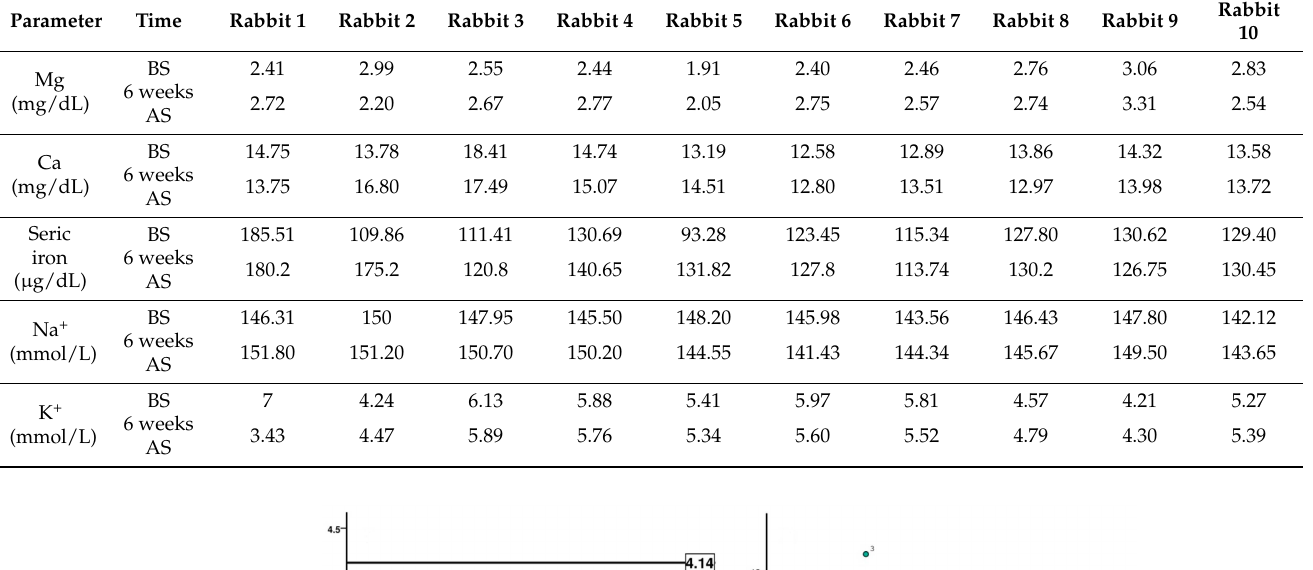
Table 8. Evolution of the SE, before and at 6 weeks after surgery.